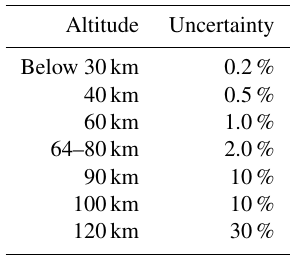
Table 3. CO 2 mixing ratio